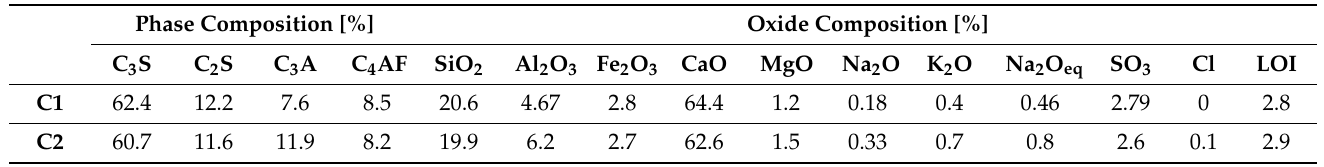
Table 2. Composition of cements C1 and